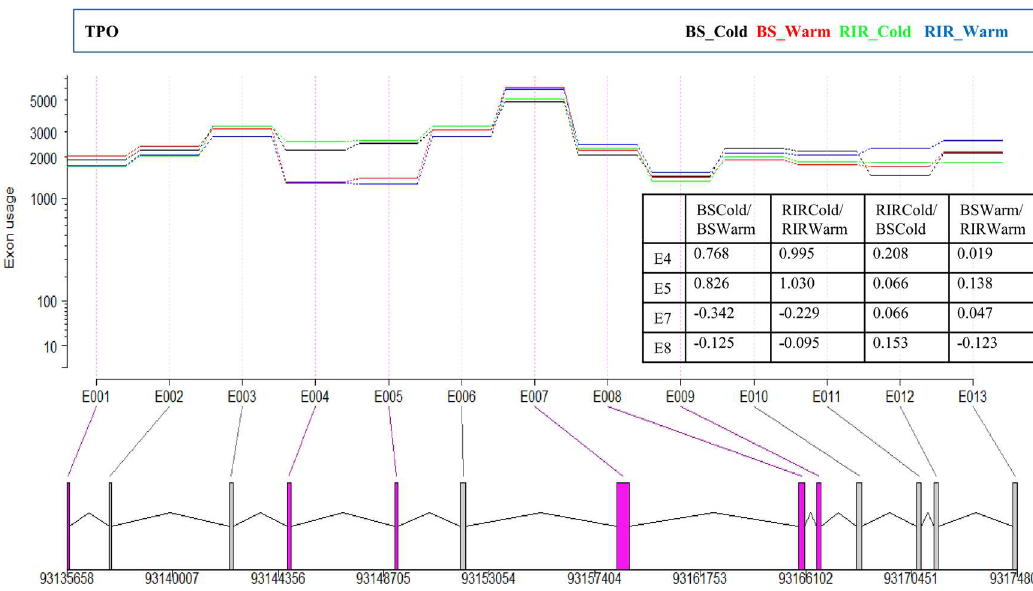
Fig 10. Differential splicing events within TPO . Exons with FDR < 0.05 are colored red (bottom panel). The table in the right panel shows the exon usage log2-fold changes in each comparison.